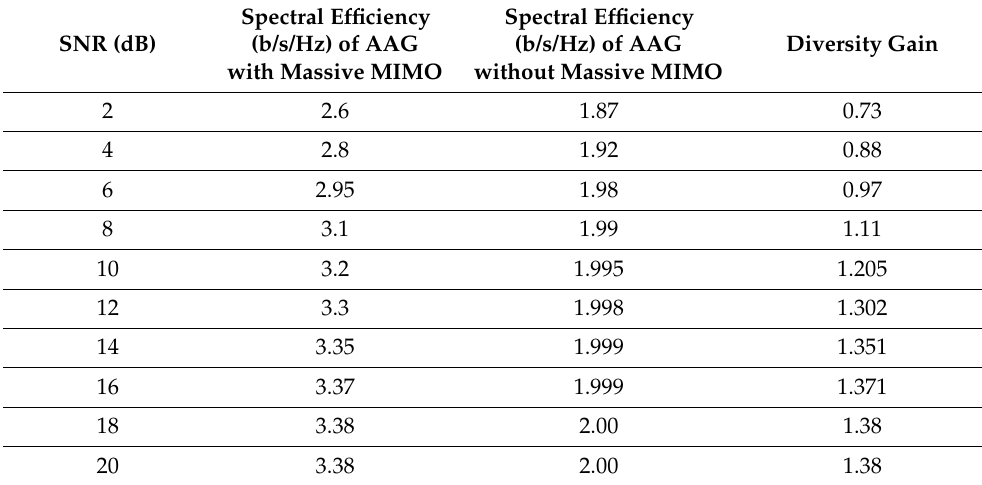
Table 4. Spectral efficiency of AAG with and without Massive